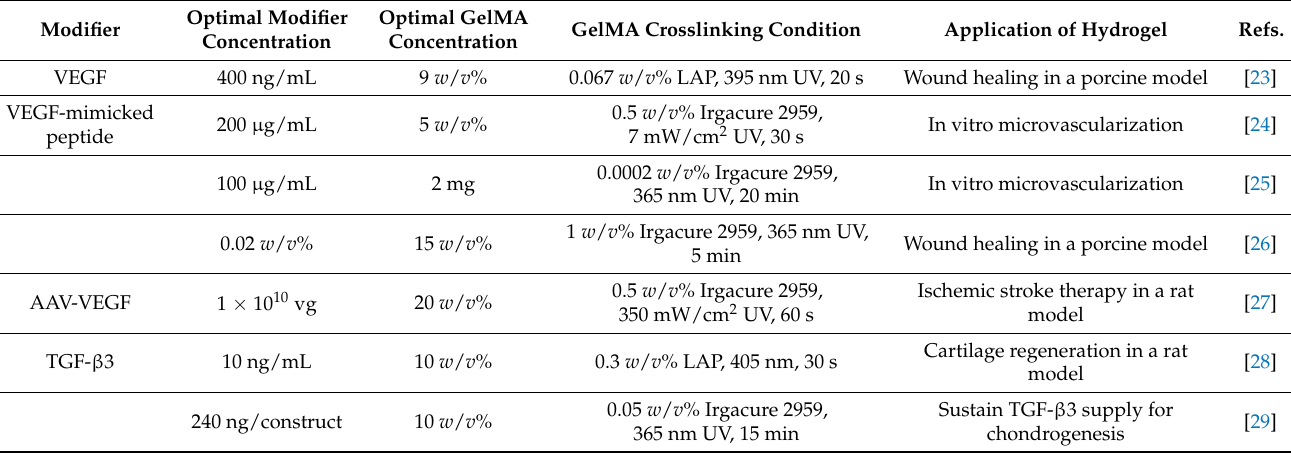
Table 1. Summary of GelMA with different modifiers for tissue engineering